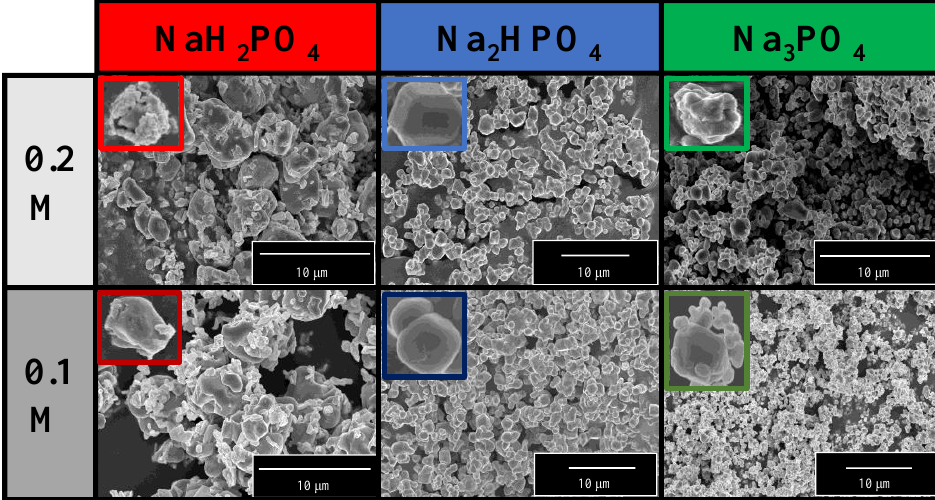
Figure 3. SEM micrographs of Ag 3 PO 4 samples synthesized by using different types (Na 3 PO 4 , Na 2 HPO 4 , and NaH 2 PO 4 ) and concentrations of phosphate sources (C = 0.1 and 0.2 M).